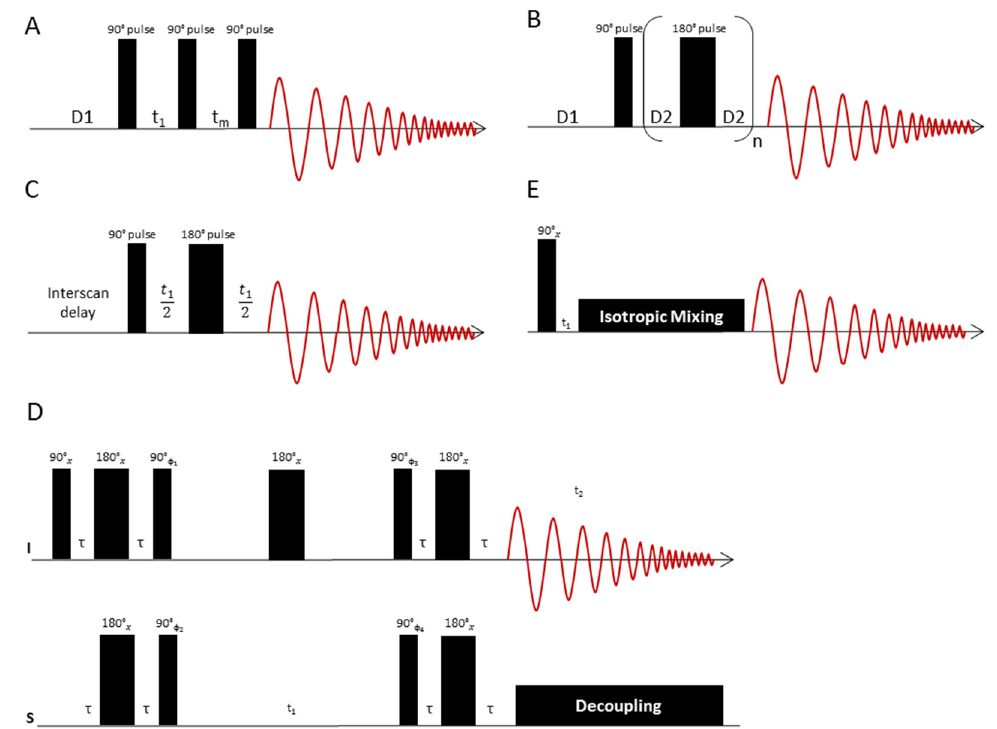
Figure 4. (A) The 1D NOESY pulse sequence consists of a presaturation interval (D1), an excitation pulse, which after a short time t 1 (phase switching time) is followed by another 90 ◦ pulse. After another time t m , the spin system is excited with another 90 ◦ pulse. During the time t m , the water saturation is switched on again to ensure complete water suppression. D1 denotes the relaxation delay time. (B) Representation of the CPMG pulse sequence: After a presaturation interval (D1), the spin